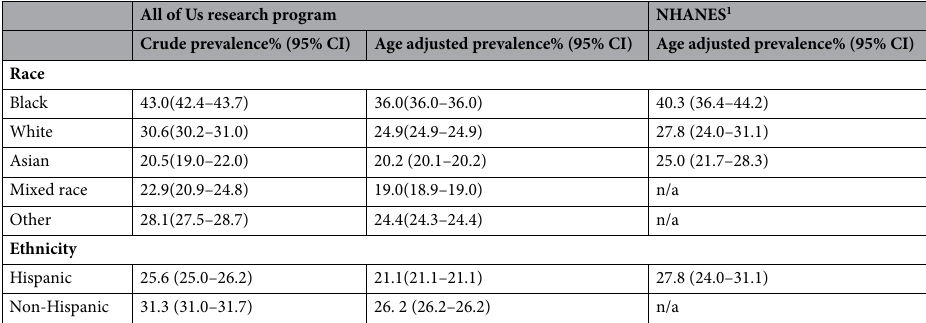
Table 4. HTN prevalence in the All of Us R esearch P rogram among race/ethnic groups adjusted for age based on U.S. Census data for age distribution of the population in 4 groups, 18–39, 40–59, 60–74, ≥ 75. 1 All estimates are age adjusted by the direct method using computed weights based on the subpopulation of persons with HTN in the 2007–2008 National Health and Nutrition Examination Survey, using age groups 18–39, 40–59, and 60 and over. Access data table for Fig. 4 at: https:// www. cdc. gov/ nchs/ data/ datab riefs/ db289_ table. pdf#4 SOURCE: NCHS, National Health and Nutrition Examination Survey, 2015–2016.